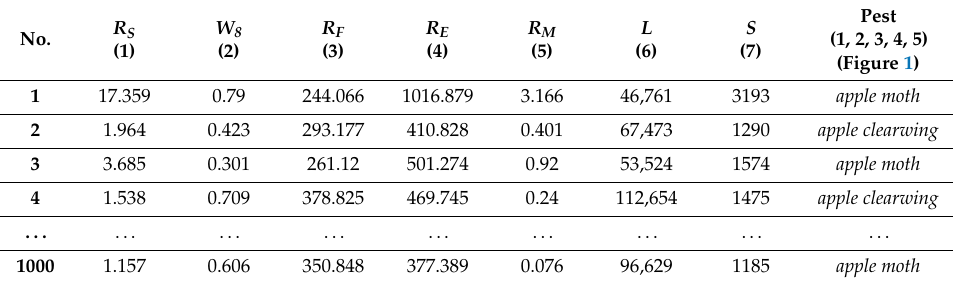
Table 1. Structure of the learning file.